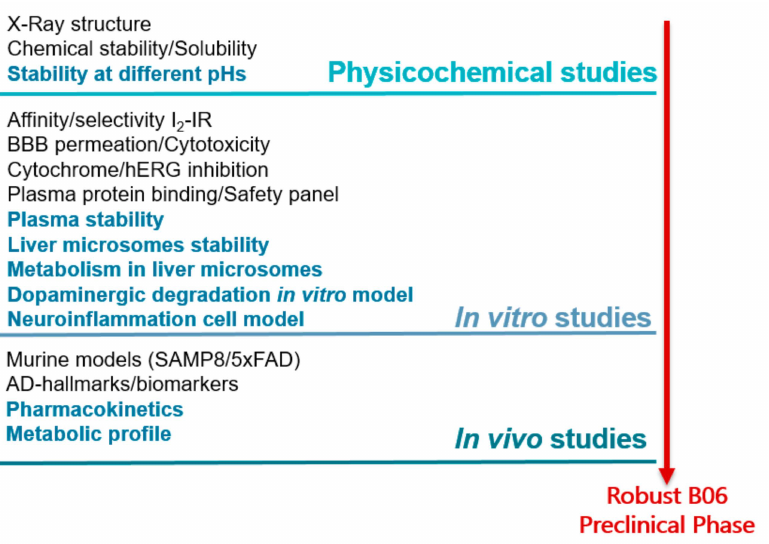
Figure 2. Summary of the previous (black) and current (blue) studies of B06